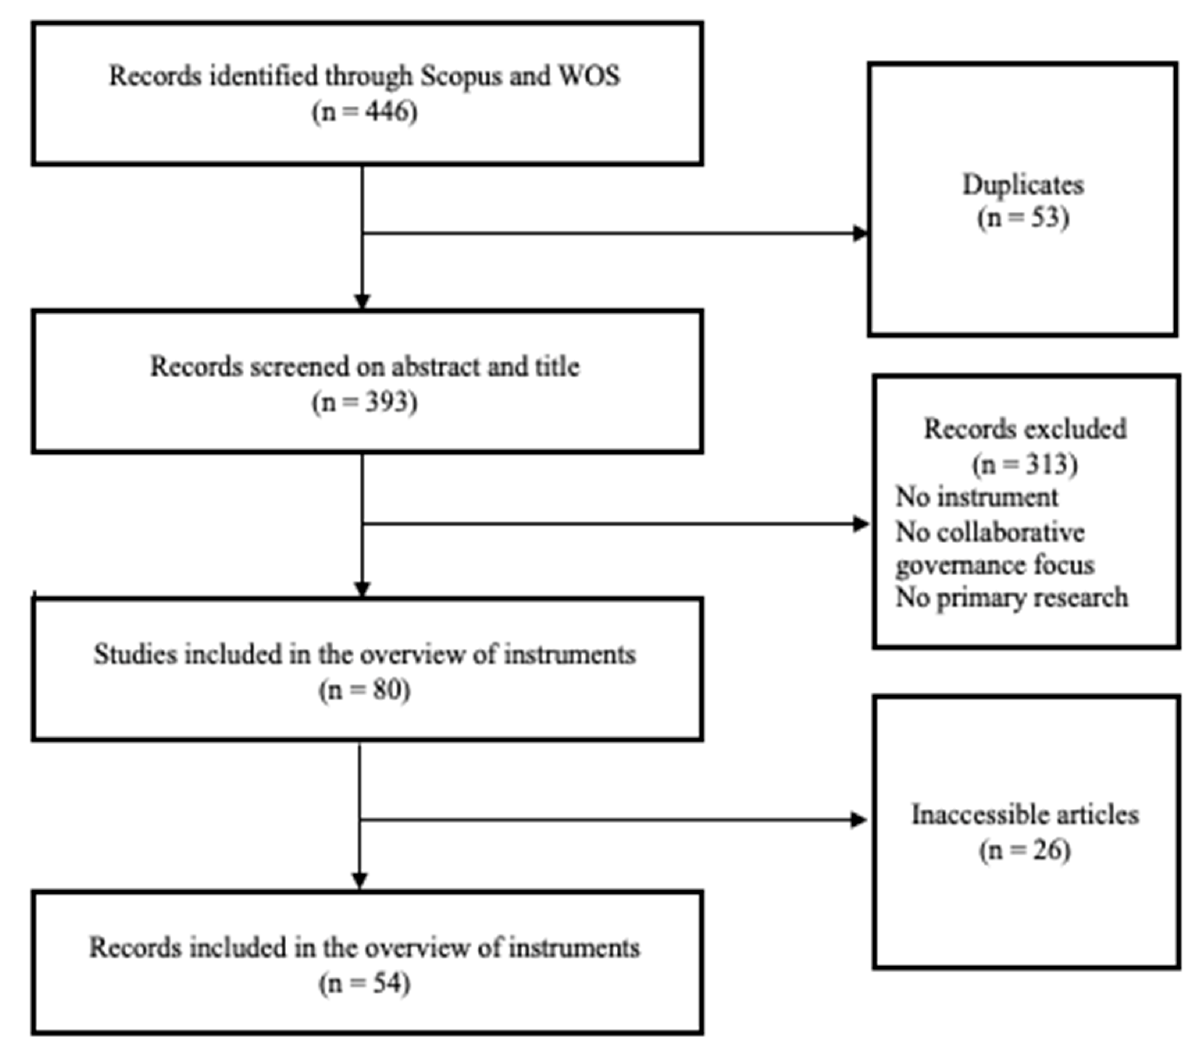
Figure 1. Flow diagram of the academic search strategy.